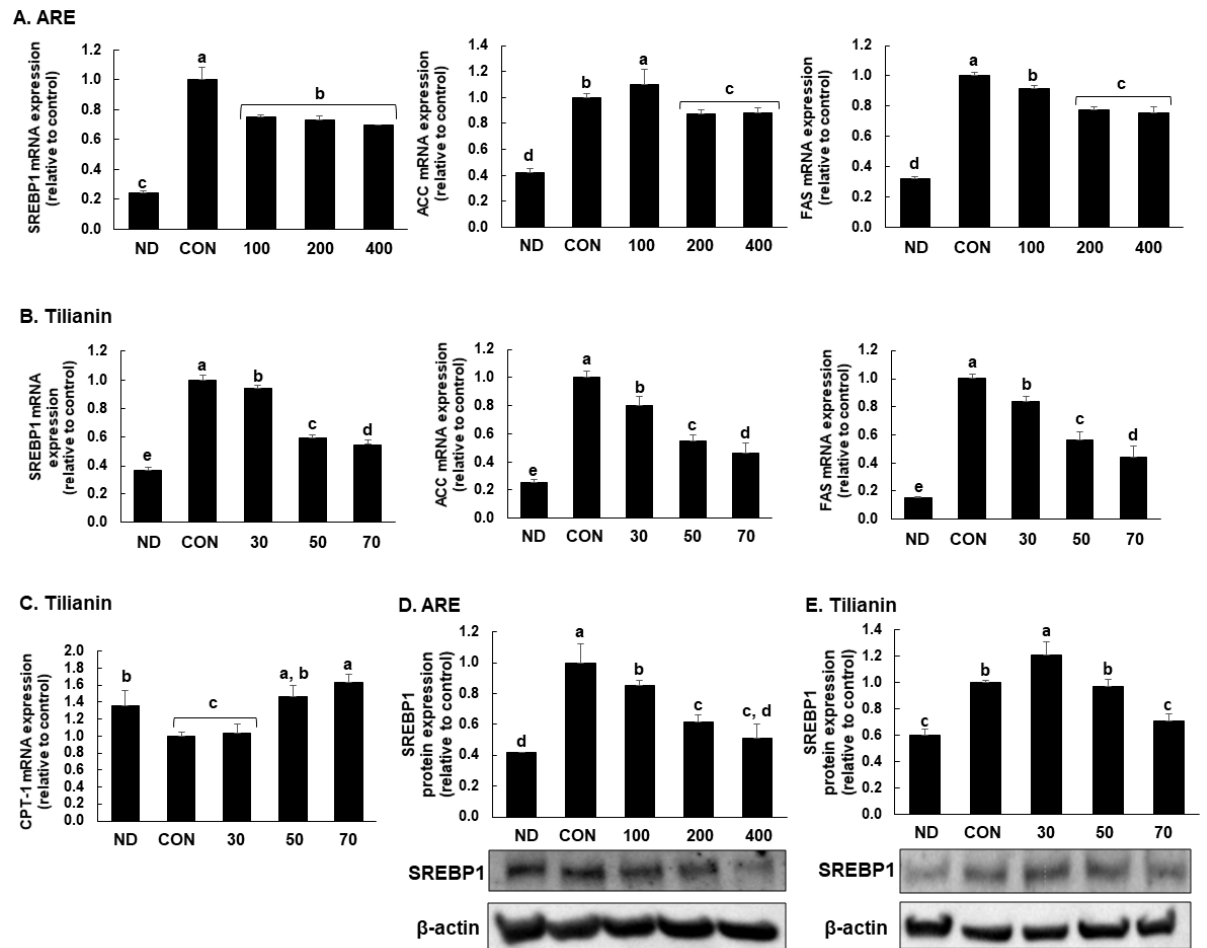
Figure 5. Anti-lipogenic effect of ARE and tilianin on mRNA and protein level and lypolytic effect of tilianin on mRNA level of 3T3-L1 cells. ( A ). mRNA expression of ARE-treated group (n = 3). ( B , C ). mRNA expression of tilianin-treated group (n = 4). ( D ). SREBP1 protein expression of ARE-treated group (n = 3). ( E ). SREBP1 protein expression of tilianin-treated group (n = 3). Different letters (a–e) indicate significantly different values in samples ( p < 0.05, ANOVA Duncan’s test).